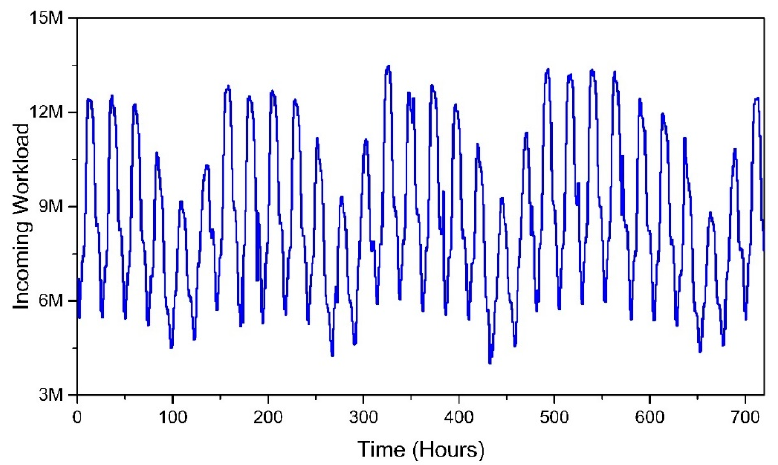
Figure 2. The traces of incoming user requests.